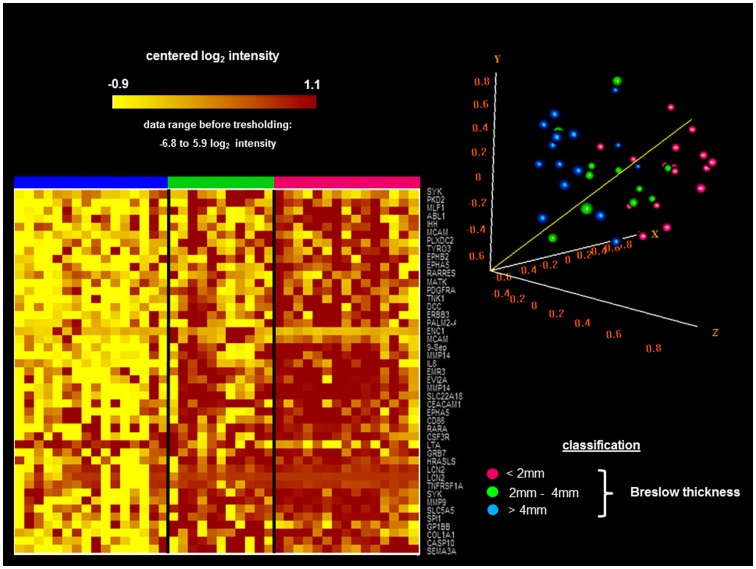
Hypermethylation is an early event in melanomas and decreases with tumour thickness.(A) The heatmap demonstrates the hypermethylation patterns (indicated in brown colour) of 45 CpGs, which can be detected in the early stages of melanomas (horizontal purple colour) but decrease from the medium stage (horizontal green colour) to the late stage (horizontal blue colour). (B) The principal component analysis for the distinction of the Breslow thickness the sample groups (large: blue dots; medium: green dots; and small melanoma samples: purple dots) based on the 45 differentially methylated CpGs. The analysis revealed that, according to the first three components, which covered the 56% of the total variance, the three groups were significantly different (p<0.05)